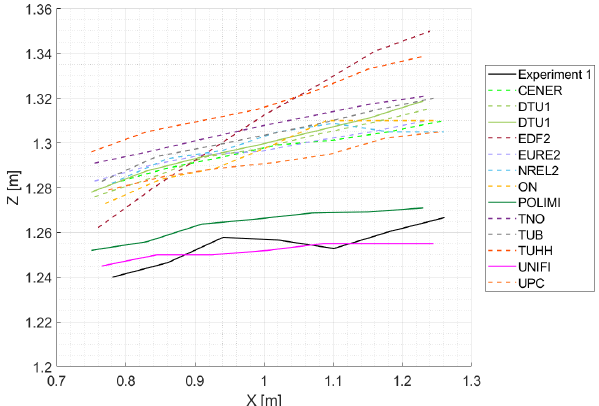
Figure 10. Averaged blade-tip vortex trajectory in the PIV plane during steady